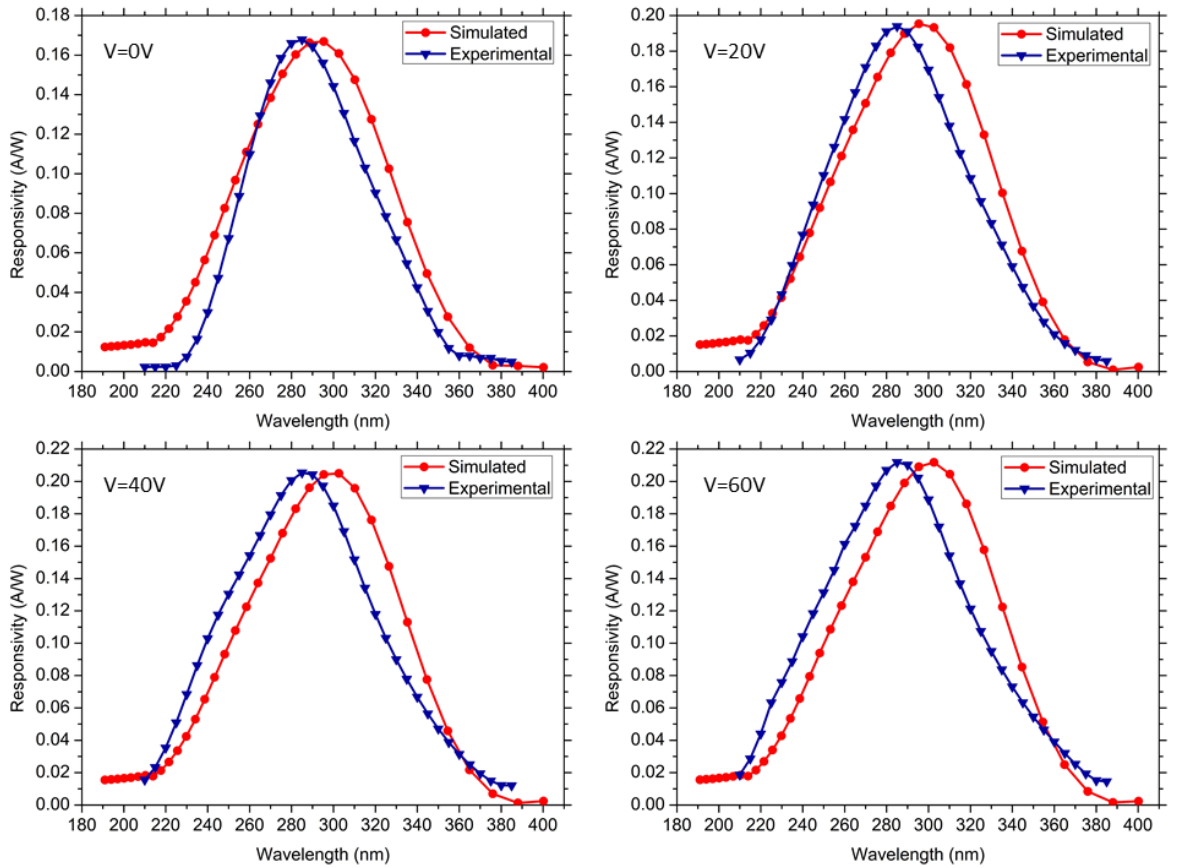
Figure 9. Comparison between the simulated 4H − SiC p − i − n UV photodiode responsivity and the experimental result at 0 V, 20 V, 40 V, and 60 V.